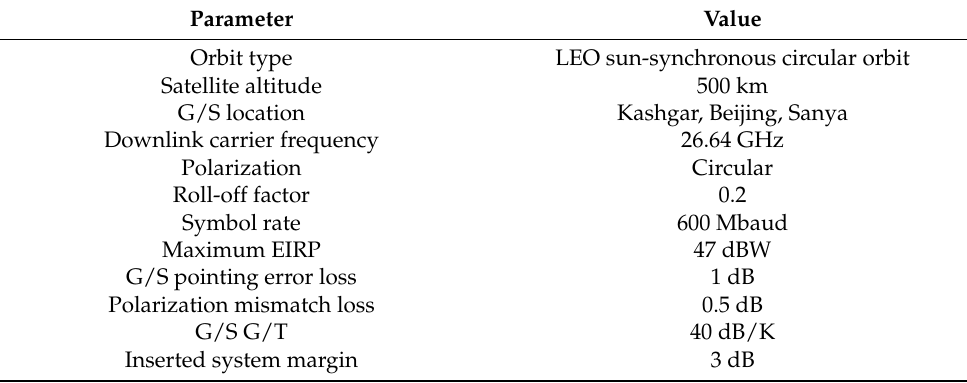
Table 2. System parameters and link budget characteristics of the end-to-end simulation.